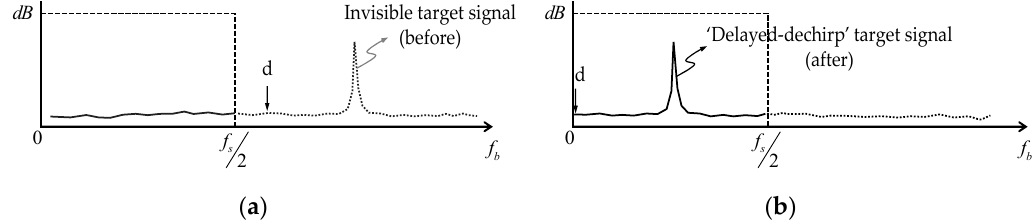
Figure 4. Beat frequency spectrum readjusted by the delayed-dechirp process: ( a , b ) is before and after applying the delayed-dechirp process, respectively.